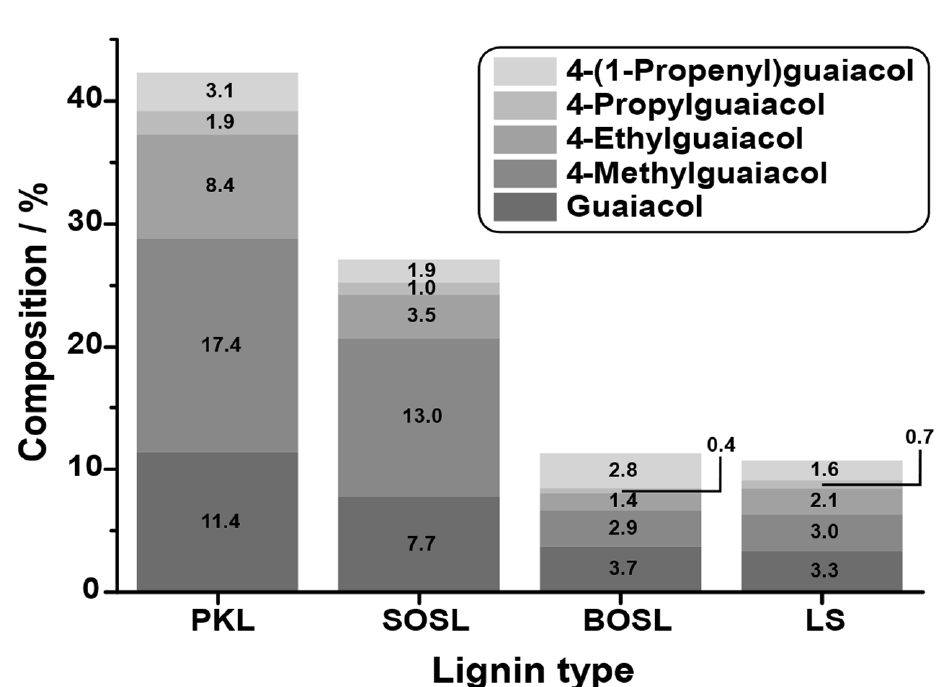
Figure 9. Mass percent of the main chemical products guaiacol (very dark grey), 4-methylguaiacol (dark grey), 4-ethylguaiacol (grey), 4-propylguaiacol (light grey), and 4-(1-propenyl)guaiacol (very light grey) in the phenolic pyrolysis fraction of the four technical lignins: PKL, SOSL, BOSL, and LS. The results indicate that a higher phenolic fraction yield also results in a higher percentage of monomers in the bio-oil. Thus, it is likely that the main difference in the yields originated from more monomers being cleaved overall. Due to the low yield of